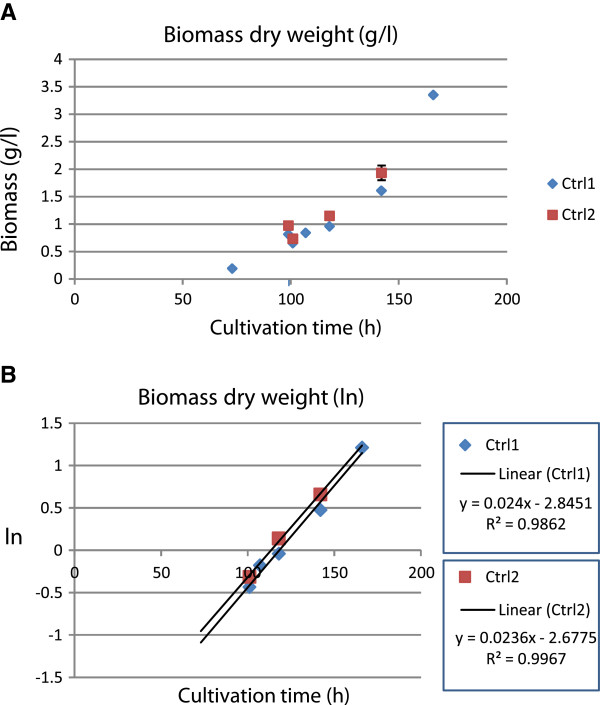
Growth curves of the control cultures in the induction experiments. Biomass dry weight at different time points of cultivation is shown in a linear scale (A), and in a logarithmic scale (B) for calculation of the specific growth rate. Equations for the linear trend lines of the growth curve after the induction time point, 100 h, are shown in the legend of panel B.